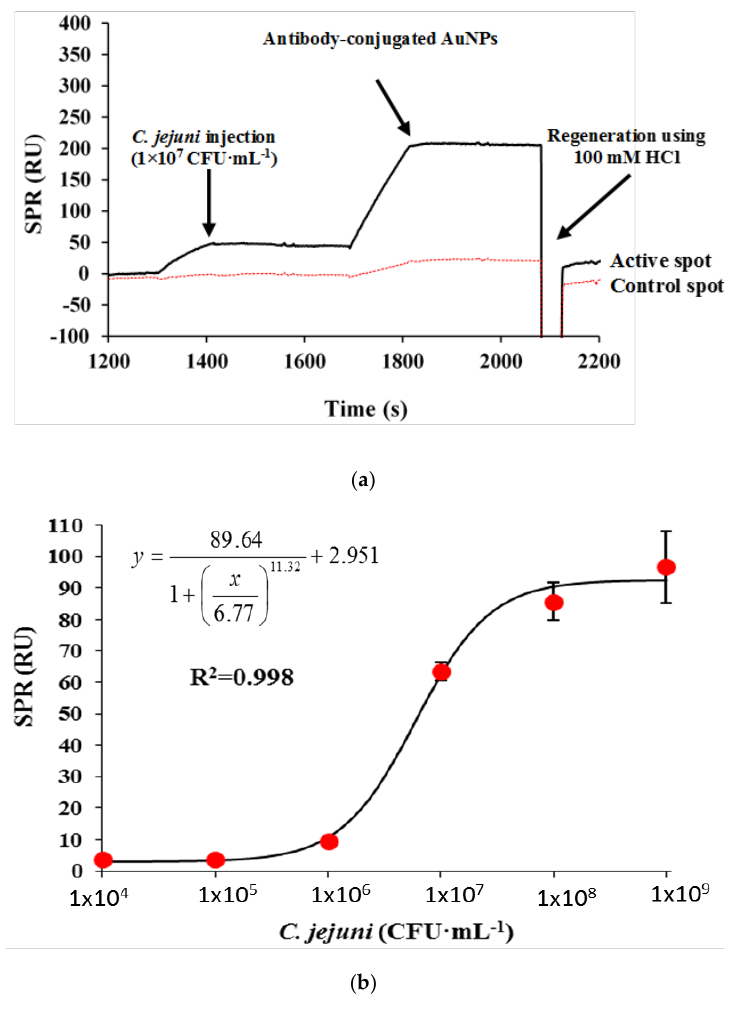
Figure 4. The SPR sensorgram showing the binding response of 1 × 10 7 CFU·mL −1 C. jejuni on the target ( C. jejuni antibody) and control (mouse IgG antibody) antibody immobilized surfaces, followed by an injection of AuNP conjugated detector antibody for signal amplification assay using nanomaterials ( a ). The corresponding C. jejuni standard curve ranging from 1 × 10 4 to 1 × 10 9 CFU·mL −1 . Bars represent mean ± standard deviation of triplicates ( b ).